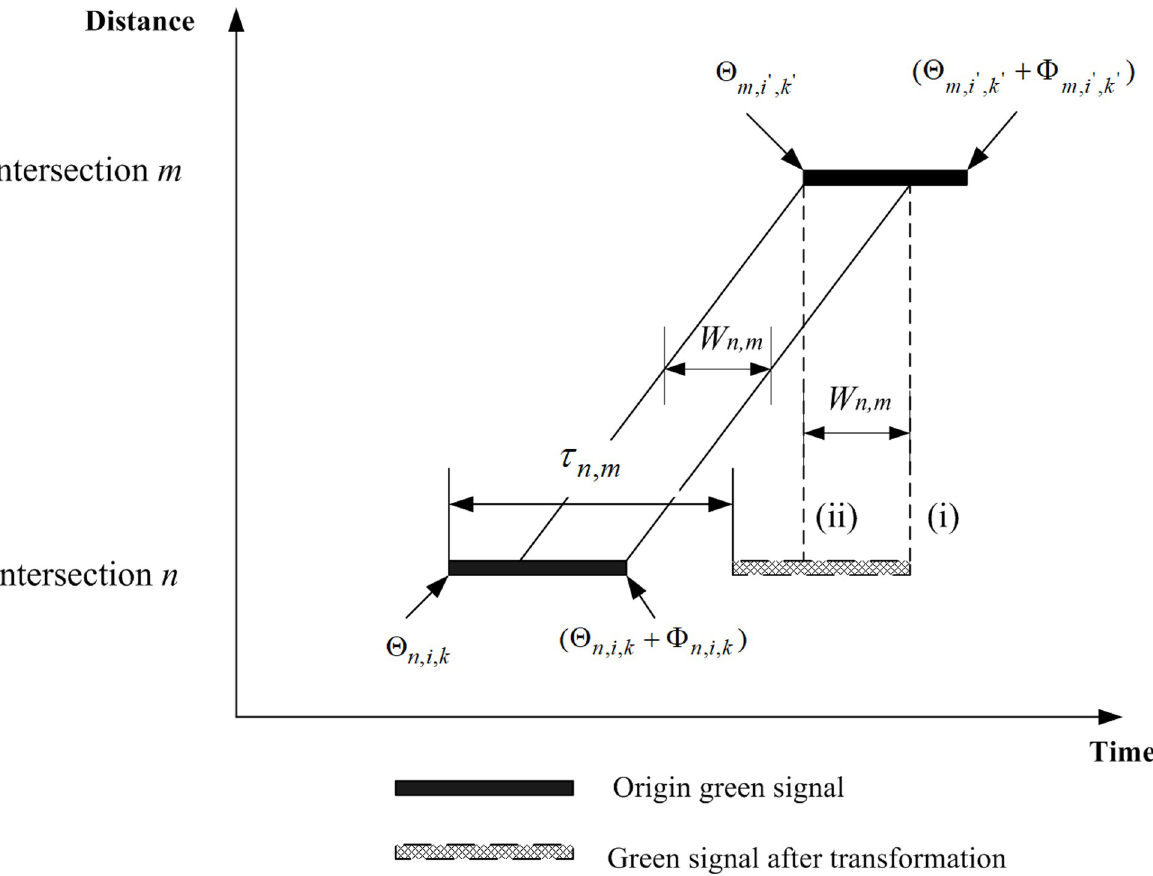
Fig 2. Typical green band between two intersections in a time-space diagram and transformation of a green signal phase for evaluating green bandwidth.